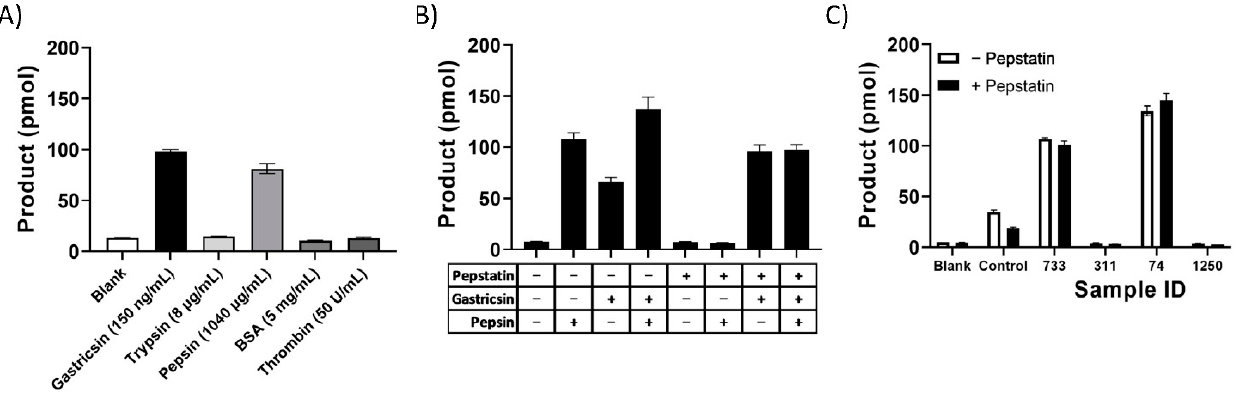
Figure 2. Gastricsin activity assay in pH 2 buffer. ( A ) The product formation is calculated from fluorescence measurement at each concentration of gastricsin as indicated on the x-axis. ( B ) The product formation calculated from SERS measurements at each concentration of gastricsin. The samples in ( A ) were used for these measurements after addition of silver. Error bars represent the standard deviation of triplicate measurements. ( C ) Correlation of product formation between SERS and fluorescence measurements from paired reaction samples. The grey area is the 95% confidence interval from a linear regression analysis with a slope = 1.075 and R 2 = 0.914.